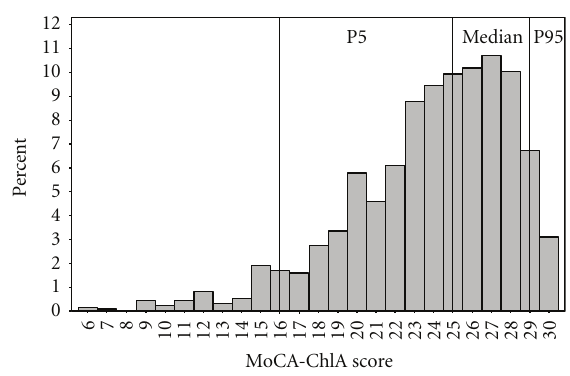
Figure 2: Distribution of MoCA-ChLA score ( N = 1192) P5: the 5th percentile P95: the 95th